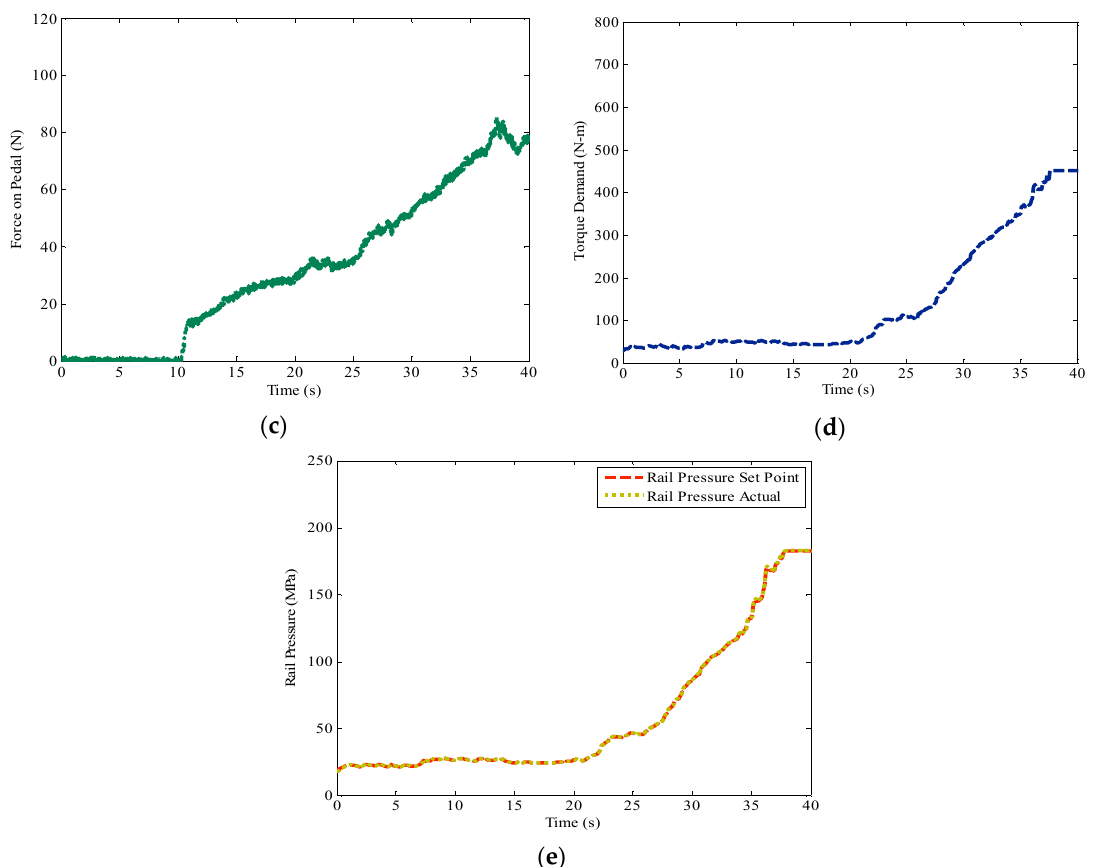
Figure 13. Test results of over speeding on common rail diesel system by the sensaptics; ( a ) sensing signal of AAP, ( b ) engine speed, ( c ) force acting on AAP, ( d ) torque demand, ( e ) rail pressure—desired and actual.